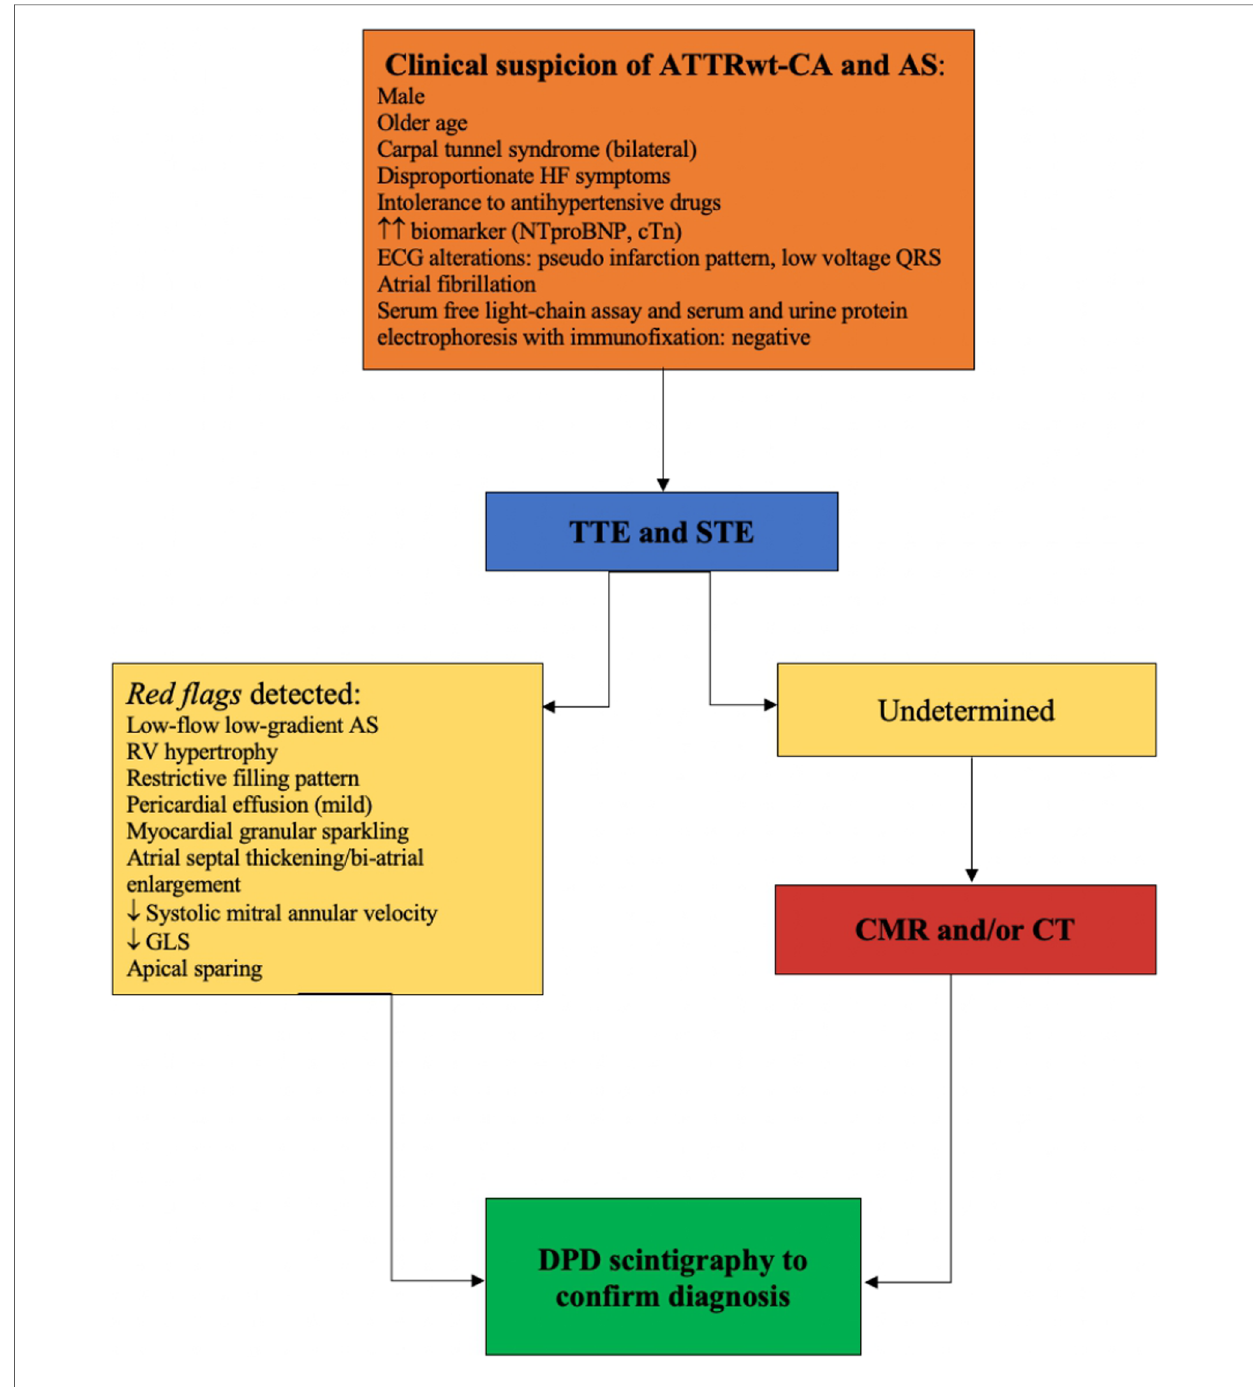
FIGURE 1 An imaging algorithm proposed to evaluate the presence of ATTRwt-CA in severe